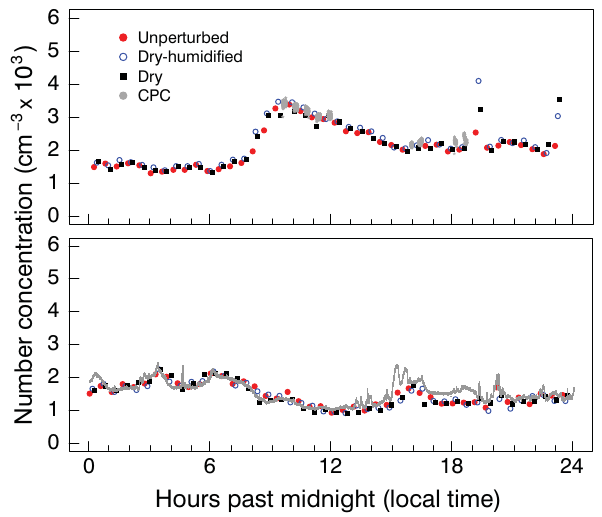
Figure 2. Top panel: example time series from 8 June. Symbols cor- respond to article number concentration obtained from integration over the size distribution (red: unperturbed; blue: dry-humidified; black: dry). Grey line corresponds to 1Hz particle concentration from the CPC upstream of the SMPS with the inlet opened to am- bient air during cleaning cycles. The plot shown here is a sample plot of the comparisons for 8 June. Bottom panel: example time se- ries from 14 July. Symbols are the same as in the top panel. Grey line corresponds to 1Hz particle concentration from a second CPC sampling side by side with the